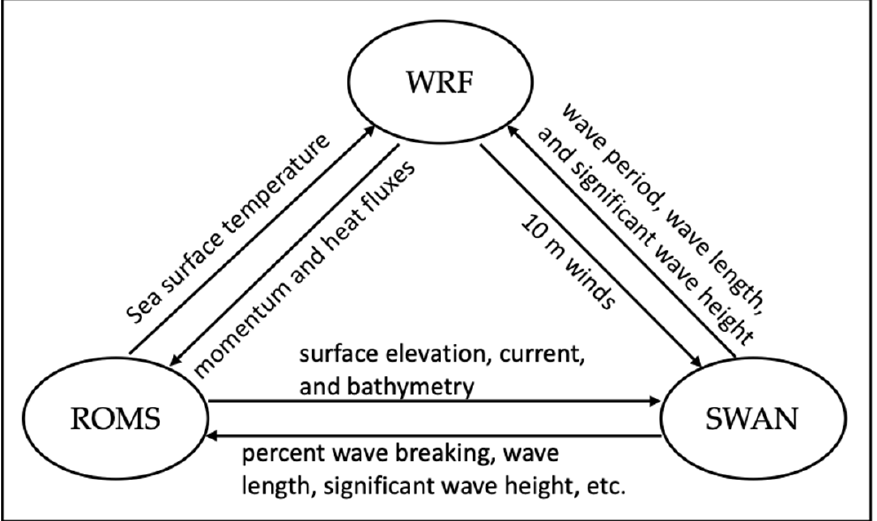
Figure 2. Data exchange between three components, i.e., WRF, ROMS, and SWAN, in COAWST.